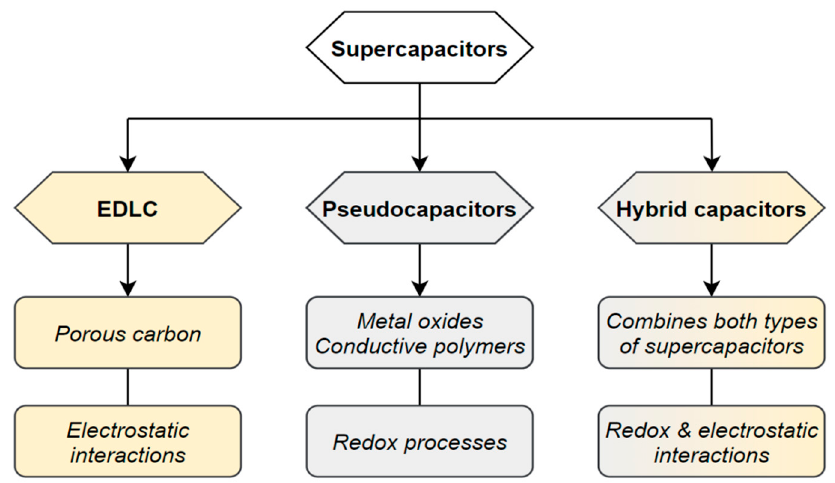
Figure 1. Classification of supercapacitors based on their energy storage mechanism, specifying the active materials and the processes involved.